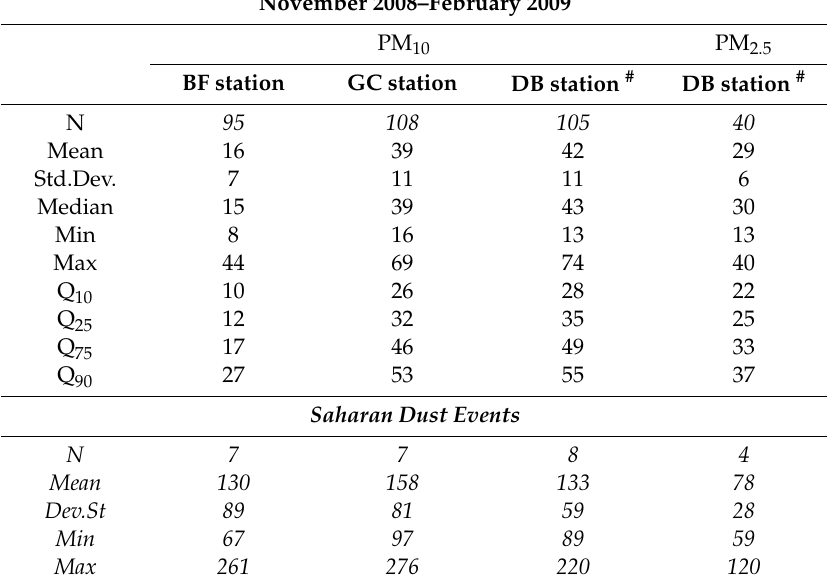
Table 1. Characteristics of PM 10 and PM 2.5 samples at the three monitoring stations during non-Saharan dust events and Saharan dust events. Mass values expressed in µ g / m 3 . # indicates measurements carried out